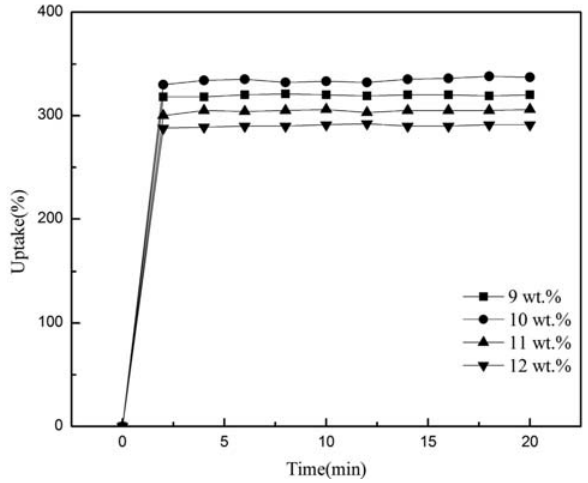
(J/g) Crystallinity χχ (%) Fig. 3. The uptake behavior of the TPU/PVDF/PS electrospun fi- f c brous films